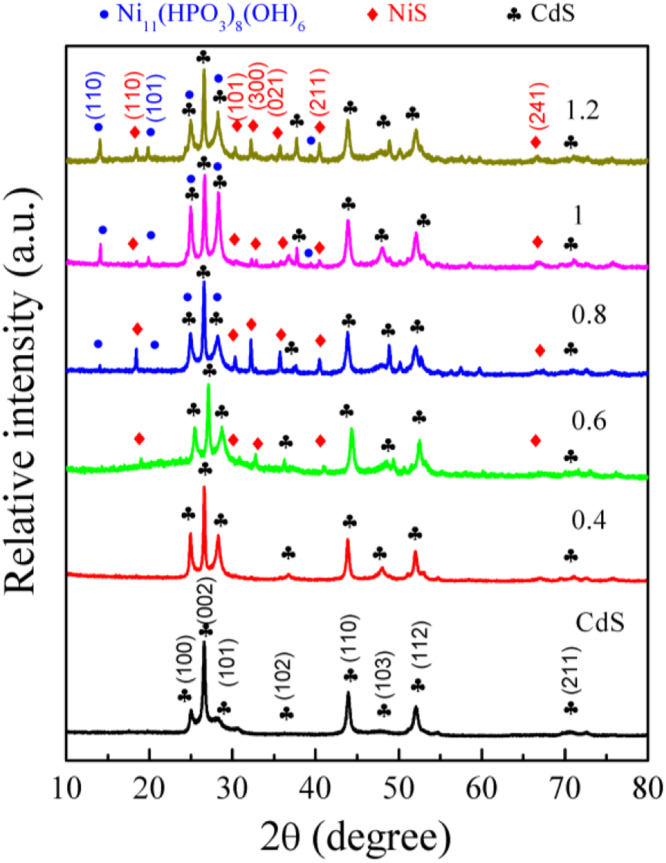
XRD patterns of pure CdS NFs, and NiS/CdS NFs HSNC prepared with 0.6 mmol of NaH2PO2·H2O but different FMRs of Ni/Cd: 0.4, 0.6, 0.8, 1 and 1.2, while the amount of Cd(NO3)2·4H2O was fixed at 1 mmol. The obtained pure CdS NFs were synthesized under the same condition as that for NiS/CdS NFs HSNCs but without Ni(CH3COO)2·4H2O and NaH2PO2·H2O (also see Table 1).